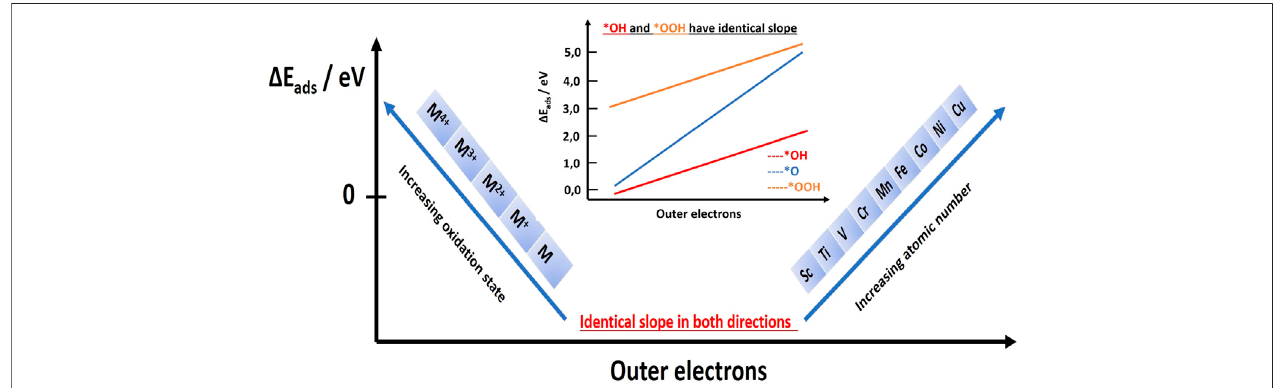
FIGURE 2 | Illustration of how the adsorption energies change with the number of outer electrons for different metals and for various oxidation states of one metal. Replotted using information from Calle-Vallejo et al. (2013). In the inset is the illustration of scaling relations indicating that the change in the adsorption energy of one of the OERintermediates, due to change in electronic con fi guration (number of outer electrons), alters adsorption energies ofthe other two OERintermediates in the same manner. Importantly, adsorption energies of *OH and *OOH are also quantitatively changing in the same manner. Replotted using data from Calle-Vallejo et al.